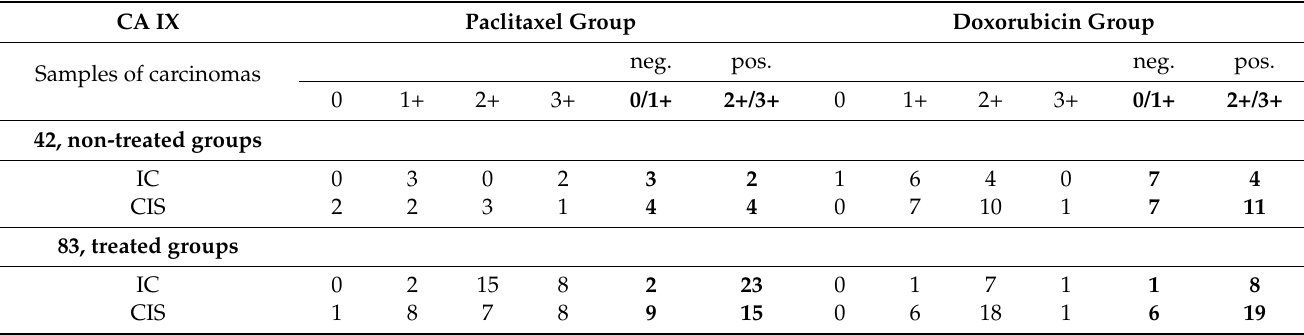
Table 2. Expression of CA IX in invasive carcinoma (IC) and carcinoma in situ (CIS) tumor samples from non-treated and treated groups of female